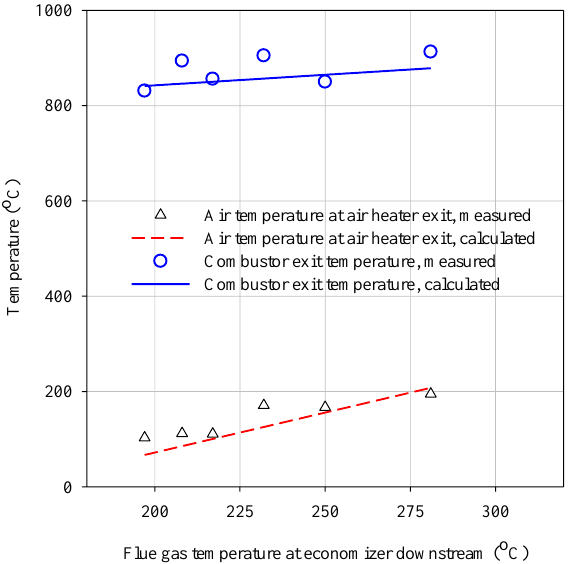
Figure 4. Effect of the economizer downstream temperature on the air temperature at the air heater exit and the flue gas temperature at the combustor exit.